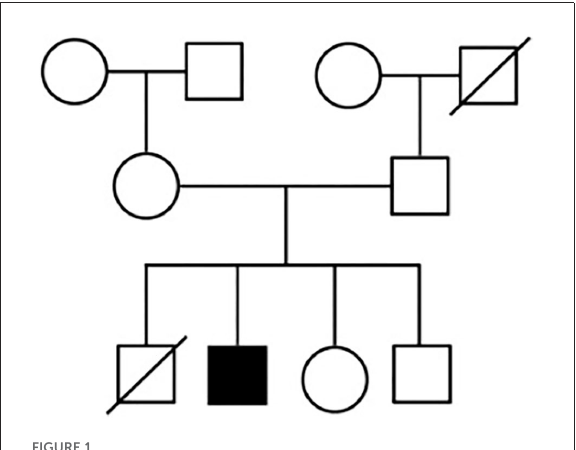
FIGURE1 Pedigree of the patient’s family.